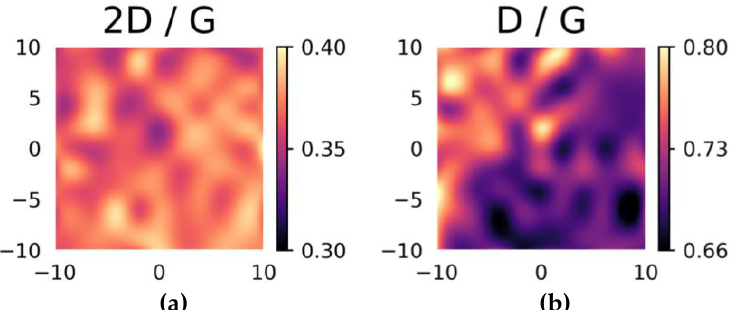
Figure 8. Maps of the Raman ( a ) 2D/G and ( b ) D/G intensity ratios recorded at an excitation wavelength of 442 nm on a 20 × 20 µm 2 area of the N-doped graphene film with no post-deposition annealing (NG-0). X - Y scales in µm.